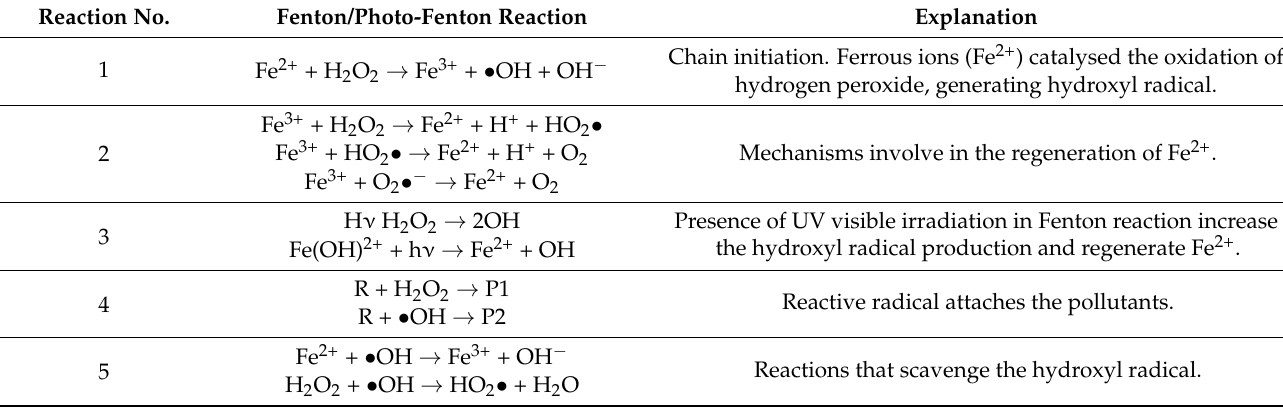
Table 5. Chemical reactions of Fenton/photo-Fenton process [37,38]. Reaction